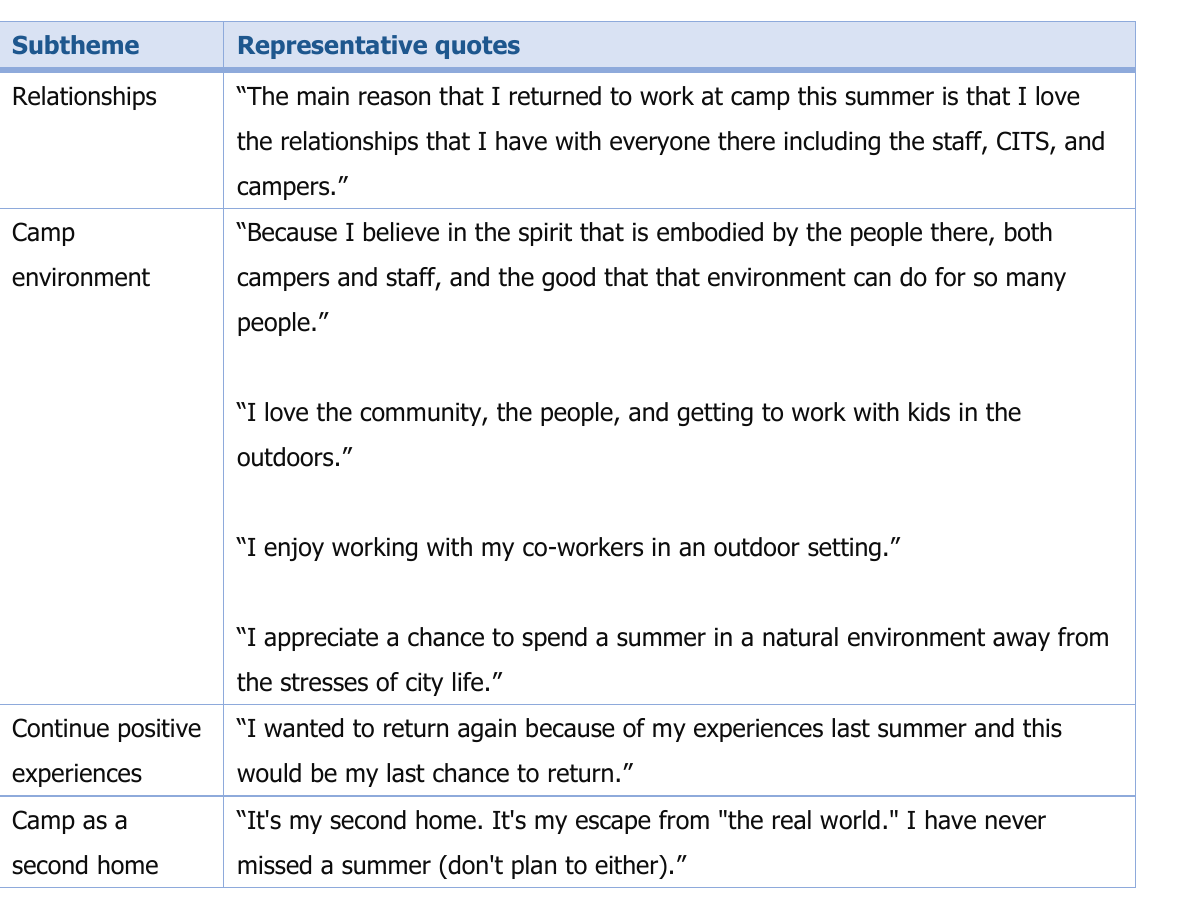
Table 6. Camp Embeddedness Representative Quotes